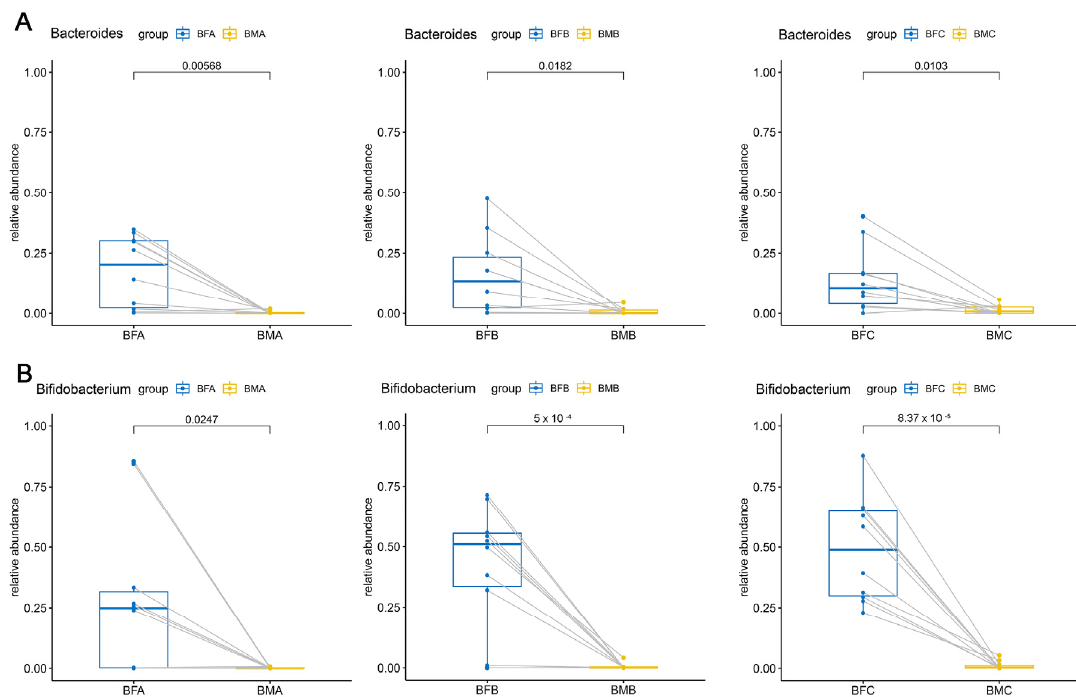
Figure 4. Different genera in human breast milk and infant feces. ( A ), significant difference of Bacteroides in HBM and infant feces. ( B ) significant difference of Bifidobacterium in HBM and infant feces. The two points connected by a line are the same mother-infant pair. BMA: breast milk (corresponding to infant younger than one month of age), BMB: breast milk (corresponding to infant between one and three months of age), BMC: breast milk (corresponding to infant between three and six months of age), BFA: infant feces younger than one month of age, BFB: infant feces between one and three months of age, BFC: infant feces between three and six months of age, BFD: infant feces between six and 12 months of age, BFE: infant feces older than 12 months of age.